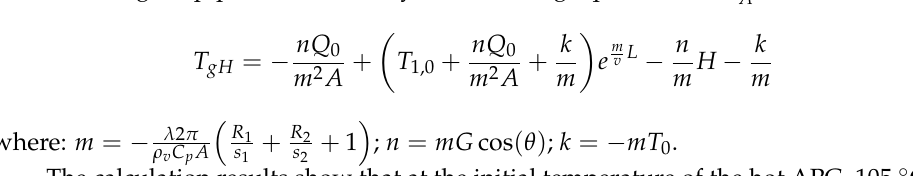
Table 1. Optimal composition of the working agent (APG) for a gas-lift well of the Dragon field.